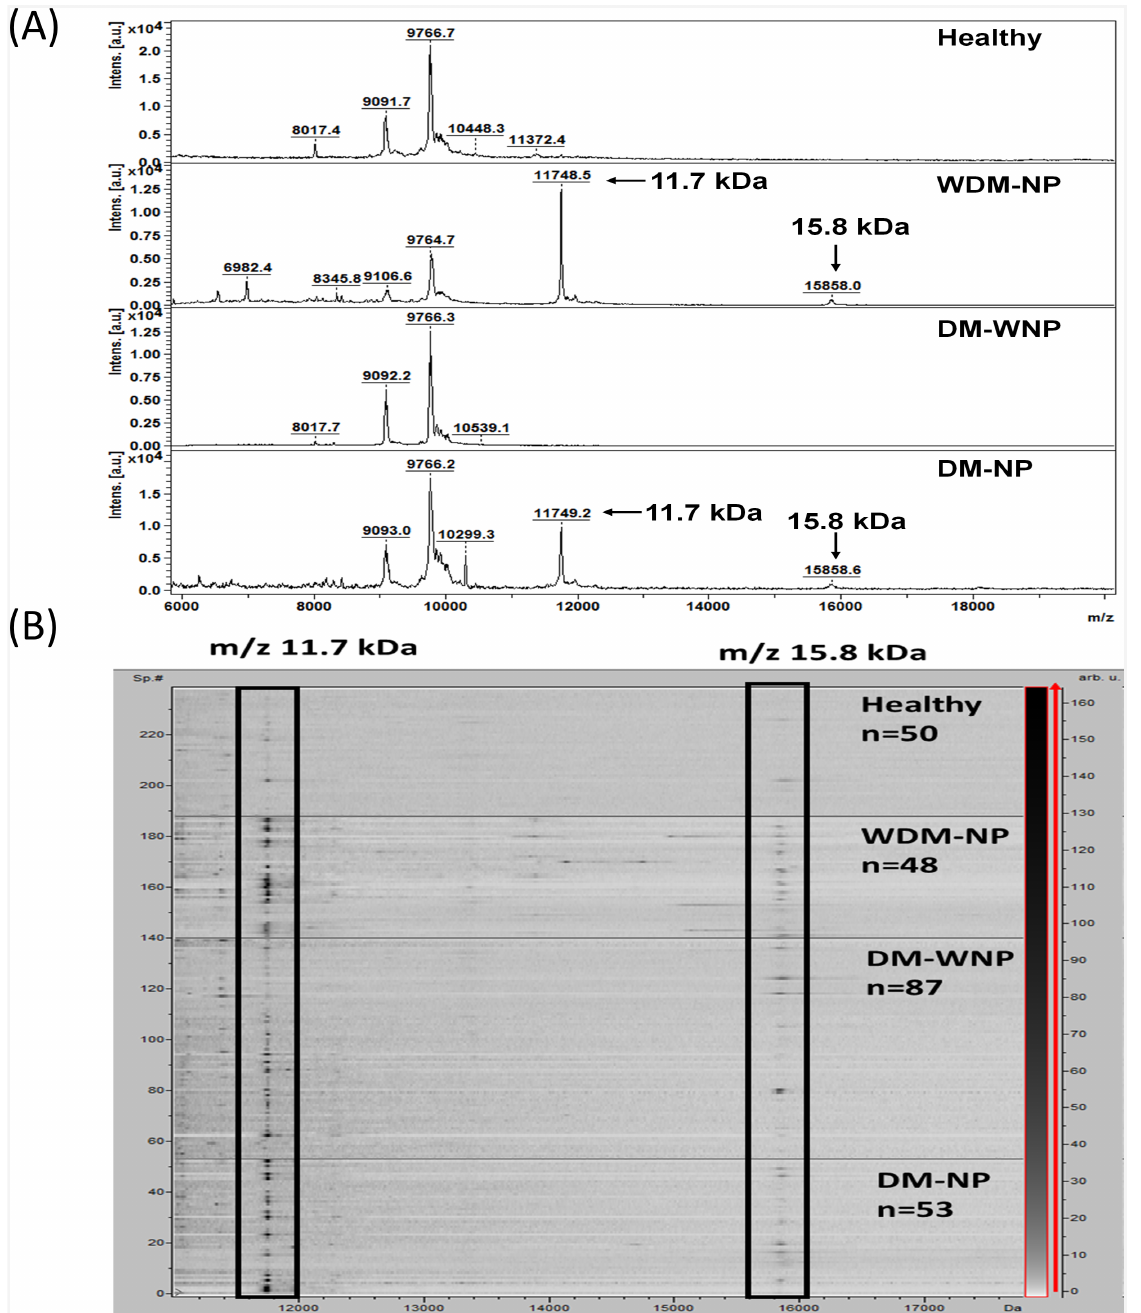
Fig 3. (A) Representative MALDI-TOF mass spectra of urine samples from a healthy individual and patients with WDM-NP, DM-WNP and DM-NP. (B) Pseudo gel view of the urine protein profiles. The horizontal line indicates the separation between the healthy, WDM-NP, DM-WNP, and DM-NP groups. The differential density along the x-axis represents the abundance of specific protein in the